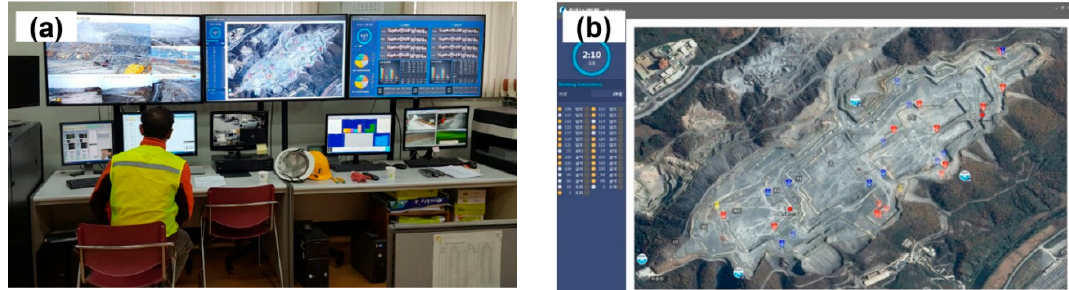
Figure 2. Mine-safety-management system for fleet management of mine equipment: ( a ) Control center; ( b ) main dashboard.